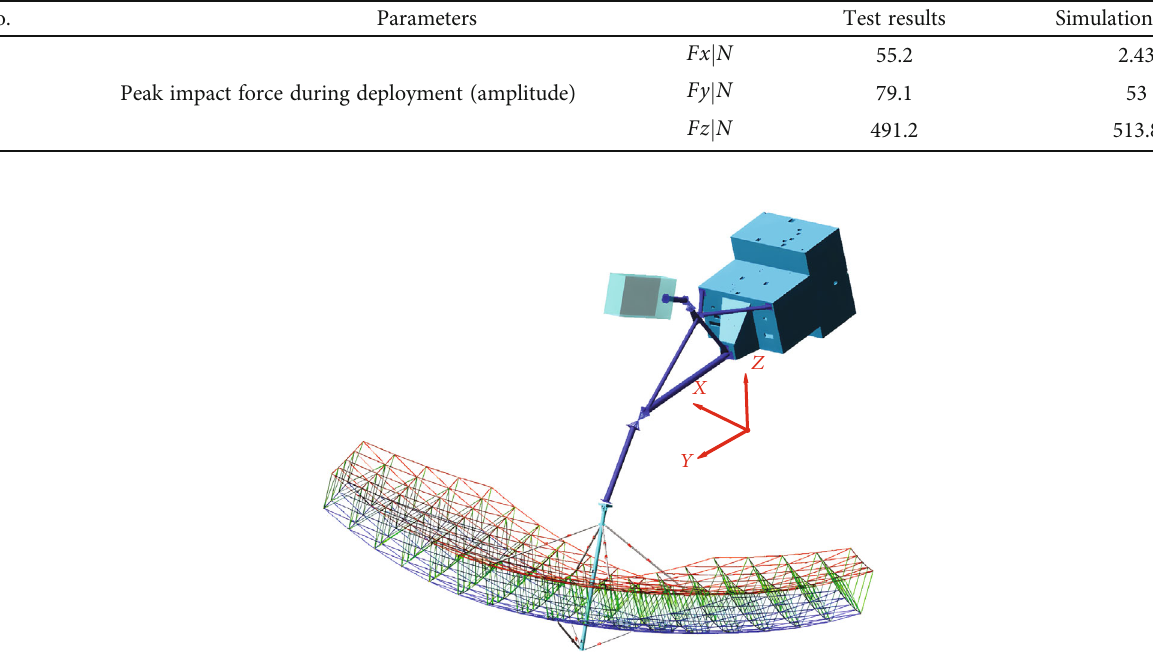
Figure 11: The schematic diagram of normal feed truss antenna